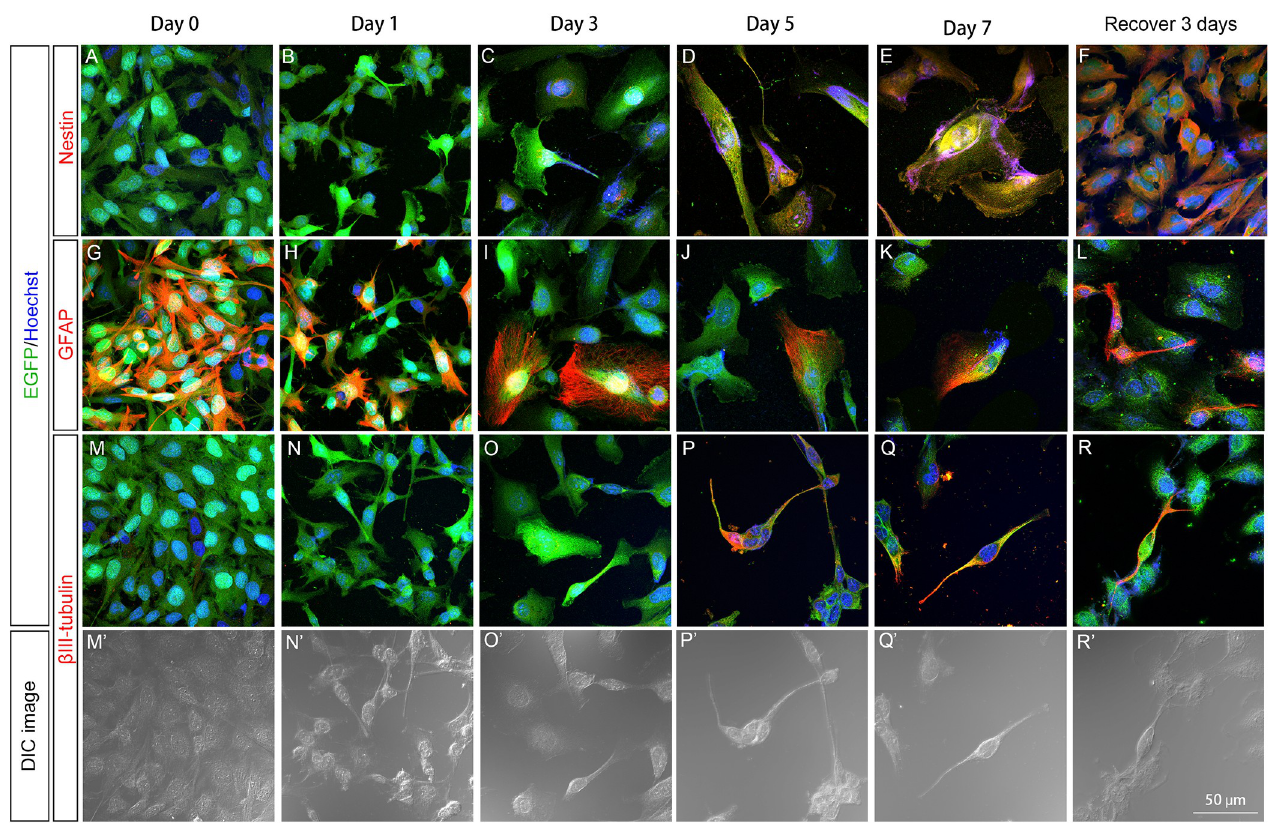
Fig 5. Patterns of nestin, GFAP, and β III-tubulin expression in U251-pCMV-HSVtk cells. U251-pCMV-HSVtk cells were treated with 5 μ g/ml GCV for 7 days, and then GCV was withdrawn to allow for cell recovery for 3 days. Immunocytochemistry of nestin (A–F), GFAP (G–L), and β III-tubulin (M–R, M 0 –R 0 ) was performed to characterize the identity of surviving cells. Increasing levels of nestin expression were detected during 7 days of GCV treatment (A–E), and strong expression of nestin was detected after recovery (F). (D–F) Filamentous expression of nestin was observed at day 5, day 7, and after recovery. U251-pCMV-HSVtk cells expressed GFAP strongly at day 0 (G), and then gradually decreased expression during 7 days of GCV treatment (H–K). (L) After recovery for 3 days, increased expression of GFAP was observed in U251-pGFAP-HSVtk cells. (G–L) Filamentous GFAP expression was observed in cell processes and cell bodies. (M–R) β III-tubulin positive neuron-like cells could not be detected until day 5 of GCV treatment and after recovery for 3 days. (M 0 – R 0 ) DIC images also revealed that β III-tubulin-positive cells had elongated processes, rounded cell nuclei, and bulging cell bodies, while other cells were smooth. Scale bar, 50 μ